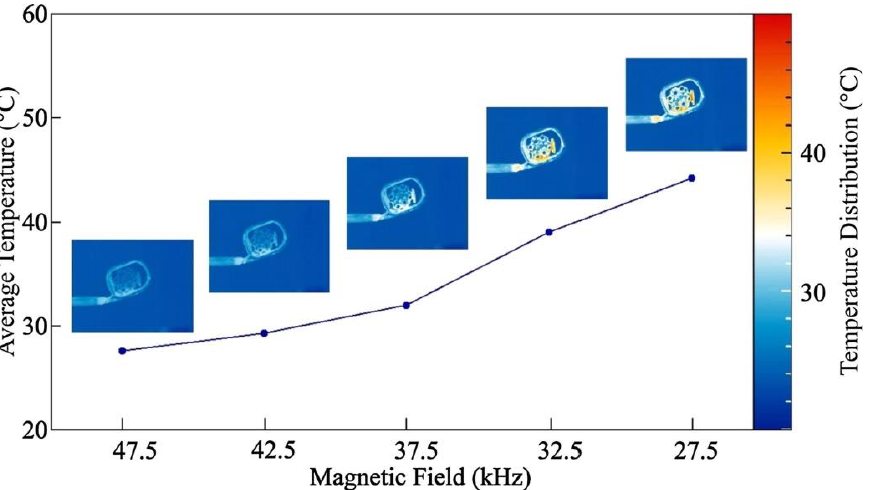
Figure 8. Correlation between average temperature of a 3D-printed specimen and external magnetic field frequency. Reprinted from [66], copyright (2019), with permission from